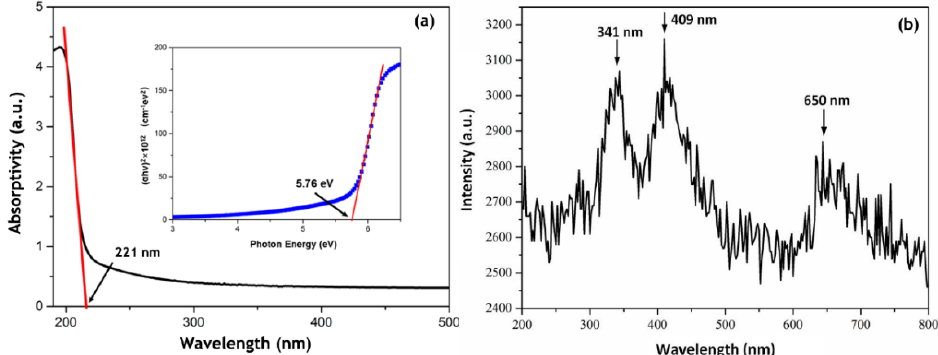
Figure 4. ( a ) The UV − Vis absorption spectrum ( b ) the CL spectrum of Fe − doped hBN fi lm. The insert shows optical band gap (5.76 eV) analysis of Fe − doped hBN from the absorption spectrum.